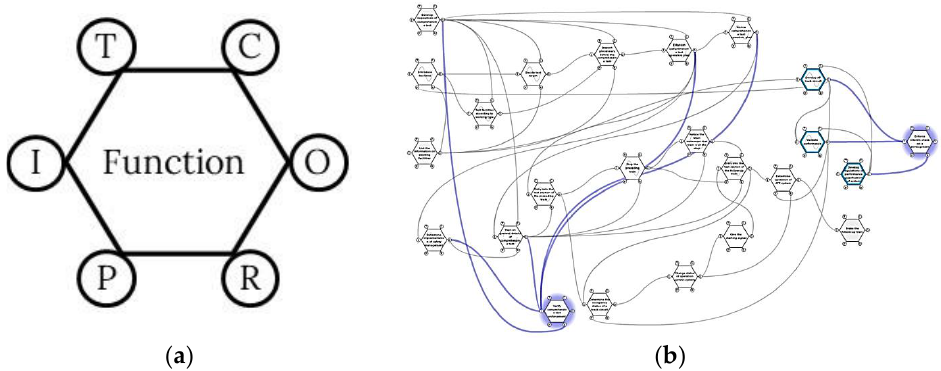
Figure 1. FRAM model. ( a ) The function representation in the FRAM model with the 6 aspects: Input (I), Output (O), Precondition (P), Resource (R), Time (T), and Control (C). ( b ) An example of the FRAM model from [25], reprinted with the authors’ permission.